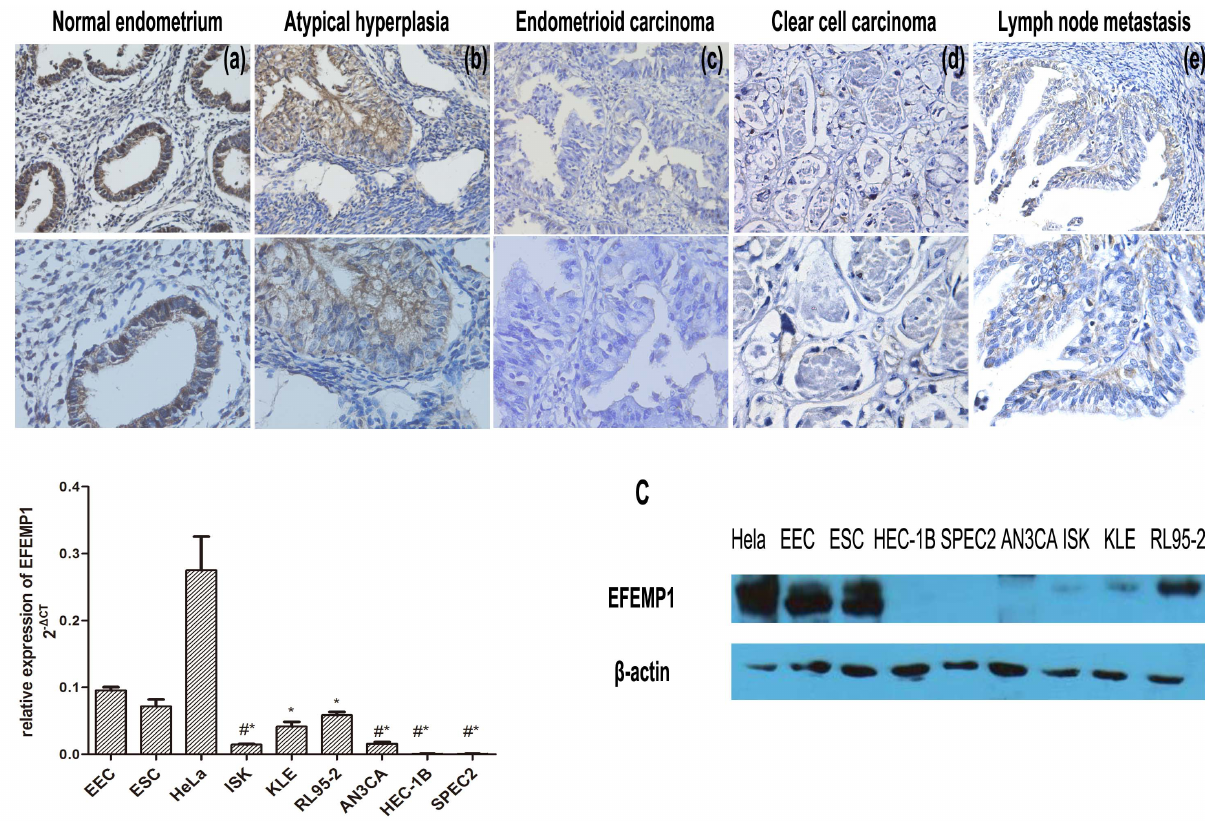
Figure 1. Differential EFEMP1 expression in normal endometrium and endometrial carcinoma. A: Immunochemistry of EFEMP1 in endometrial tissues. (a) normal endometrium with strong staining, (b) atypical hyperplasia with moderate staining, (c) endometrioid carcinoma with no staining, (d) clear cell carcinoma with no staining, and (e) serous endometrial carcinoma with lymph node metastasis. Magnification: 6 200 (above) and 6 400 (below). B: Down-regulation of EFEMP1 mRNA expression in EC cell-lines as compared with EEC (endometrial epithelial cell). ESC is the abbreviation of endometrial interstitial cell. HeLa cells were used as a positive control. The experiment was repeated twice, and each experiment was done in triplicate. * P , 0.05, # *P , 0.01. Arithmetic means of the data (bars) and SD (error bars) are shown. C: EFEMP1 expression in various endometrial cancer cell-lines as determined by Western immunoblotting analysis.